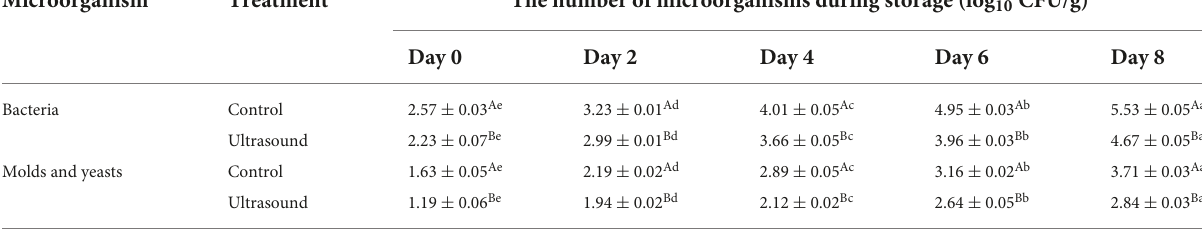
TABLE 3 Effects of ultrasonic washing on the microorganisms of fresh-cut red cabbages during 4 ◦ C storage.